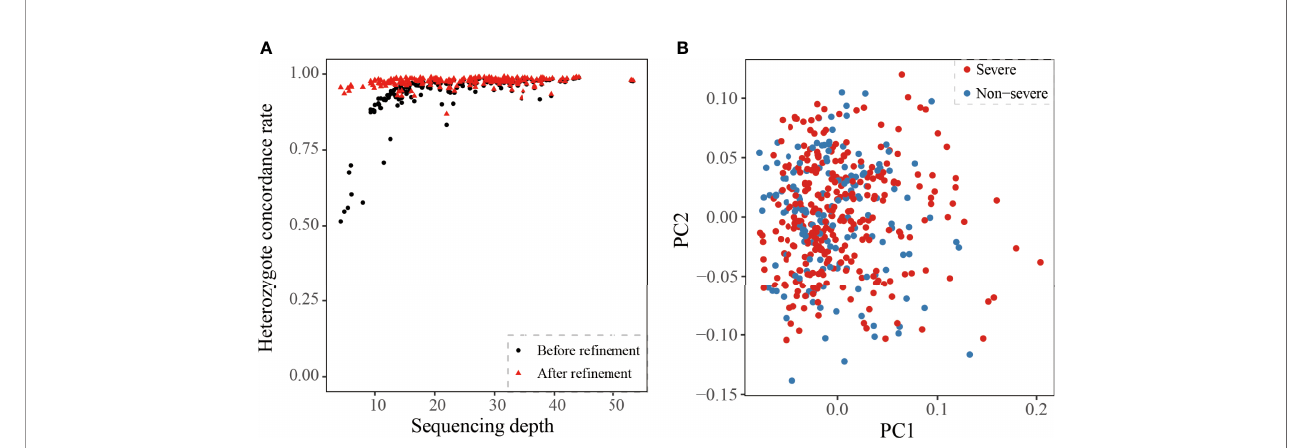
FIGURE 2 | Quality estimate of the cohort. (A) Heterozygote concordance rate vs. sequencing depth for 218 array-genotyped individuals. The black point and red triangle represent one sample before and after re fi nement. (B) PCA of 159 non-severe and 292 severe Covid-19 patients. The red and blue represent the severe or non-severe